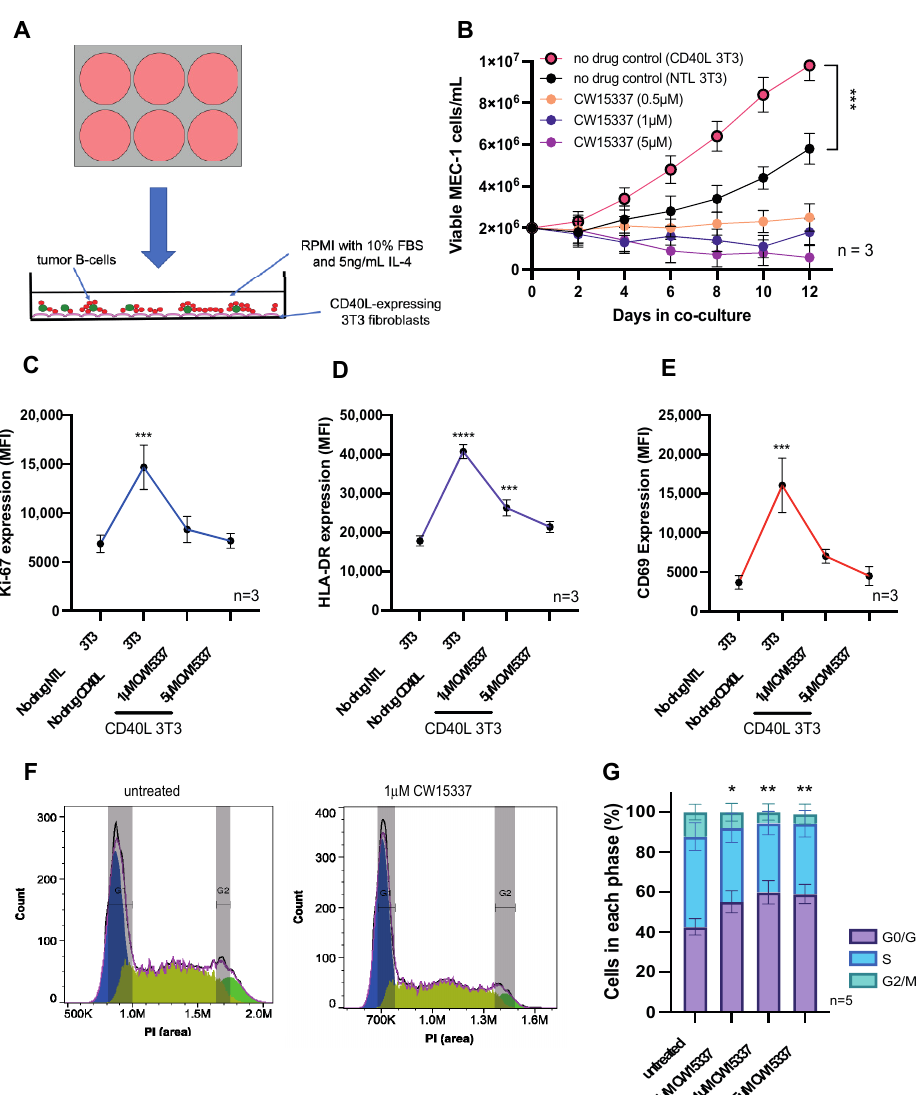
Figure 4. Co-culture on CD40L-expressing 3T3 cells drives MEC-1 cell activation and proliferation, which was reversed by the addition of CW15337. ( A ) Untransfected NIH/3T3 cells or NIH/3T3 cells transfected with human CD40L were plated prior to the addition of malignant B cells (1:10 ratio). ( B ) MEC-1 cells co-cultured on CD40L 3T3 cells showed significantly increased cell growth when compared to those cultured on untransfected 3T3 cells. MEC-1 cell growth was abolished by the addition of CW15337 to the CD40L 3T3 co-cultures. ( C – E ) In keeping with these findings, MEC-1 cells showed a marked increase in Ki67, HLA-DR and CD69 when co-cultured on CD40L 3T3 cells, which was reversed by the addition of CW15337. ( F , G ) CW15337 induced a concentration-dependent G1 arrest in MEC-1 cells co-cultured on CD40L 3T3 cells. **** p < 0.0001, *** p < 0.001, ** p < 0.01 and * p <